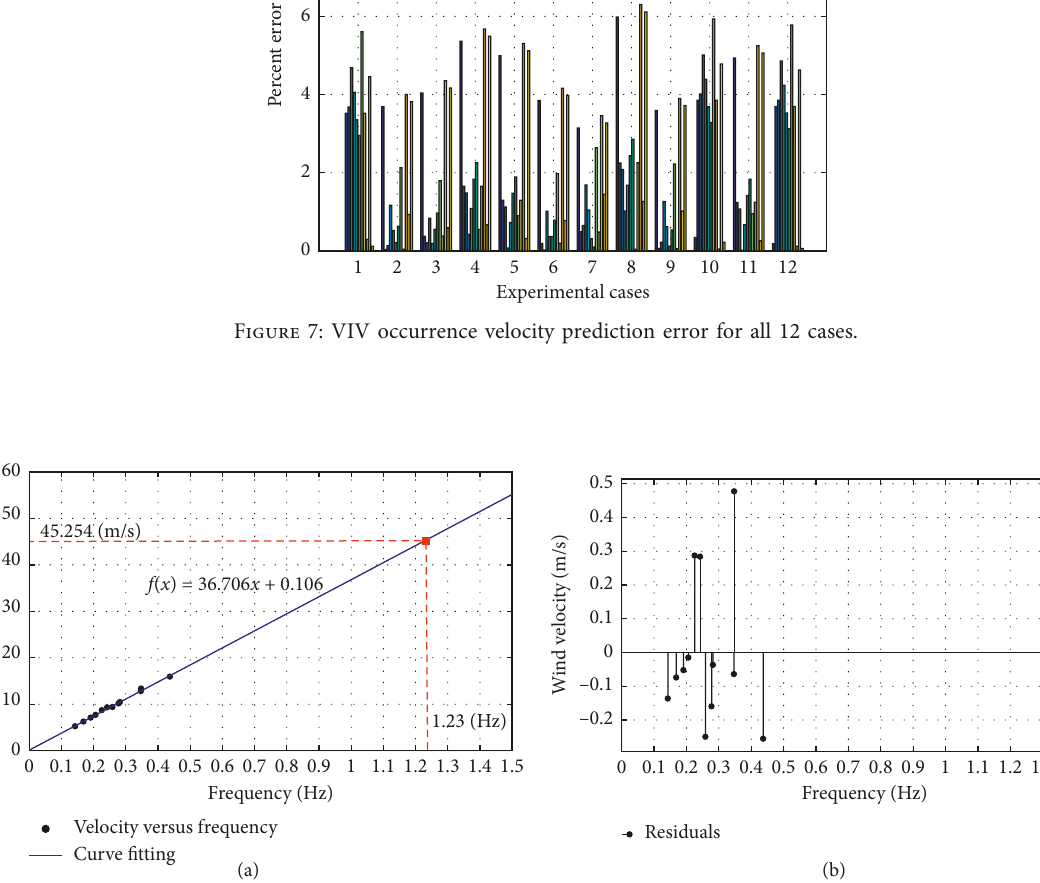
Figure 8: Wind velocity to raise VIV according to structural frequency and curve fitting. (a) Curve fitting for predicting wind velocity to raise VIV to the change of the natural frequency. (b) Residuals from the curve